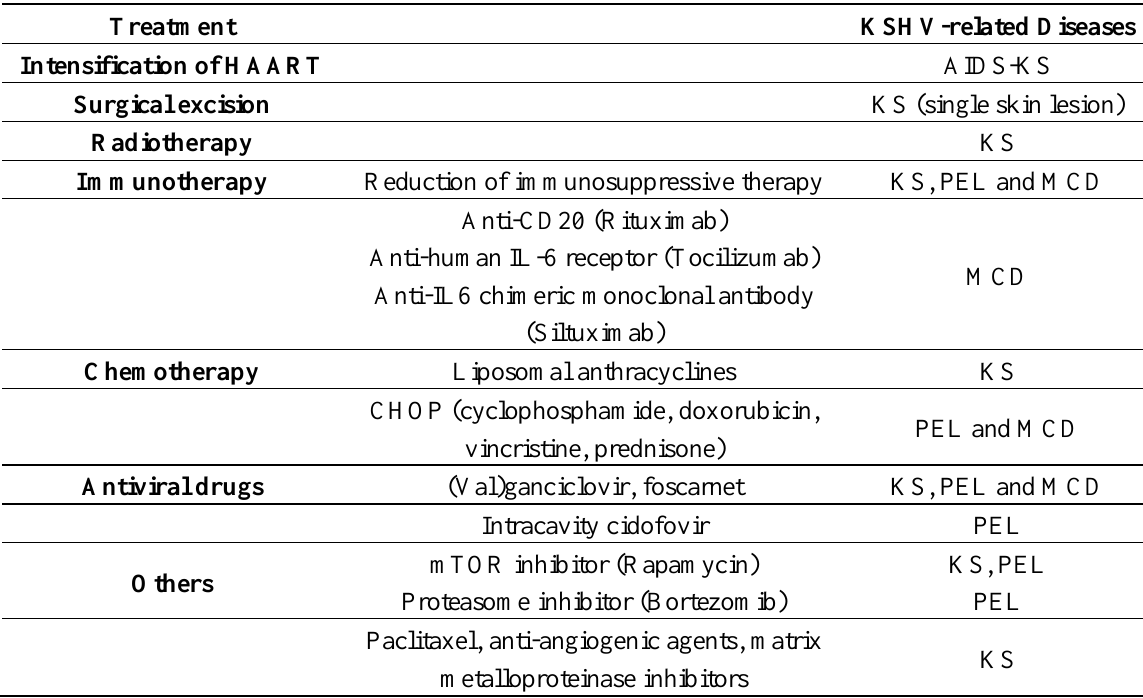
Table 1. Treatment modalities of KSHV-related